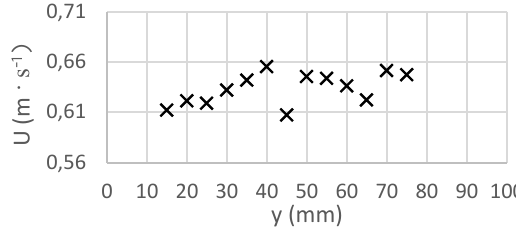
Fig. 7. Velocity profile in vertical